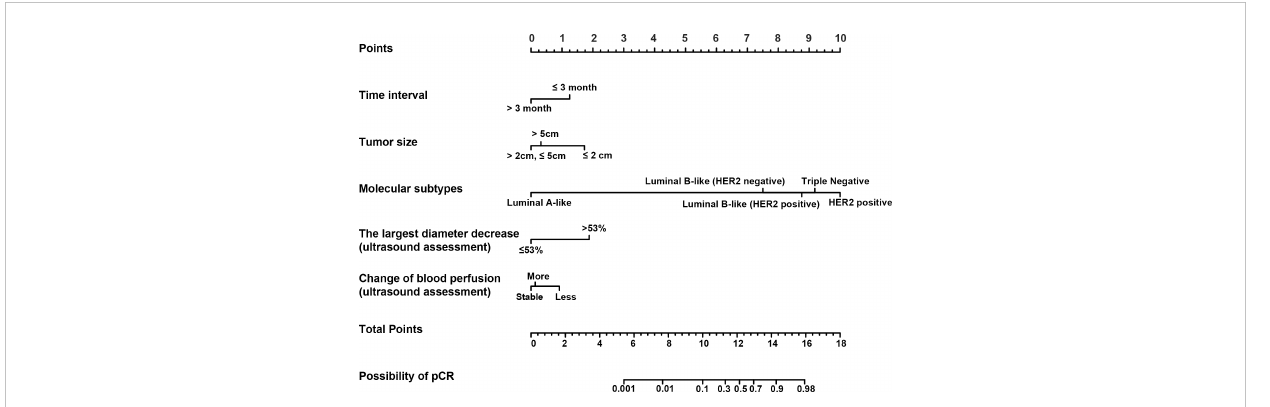
FIGURE 1 The nomogram for predicting pathological complete response (pCR) in patients with breast cancer who undergo neoadjuvant chemotherapy (NAC). Each variable was assigned a score based on its contribution to the outcome. A vertical line through each variable locates the axis that determines respective prognostic score. The total score provides an estimated probability of achieving